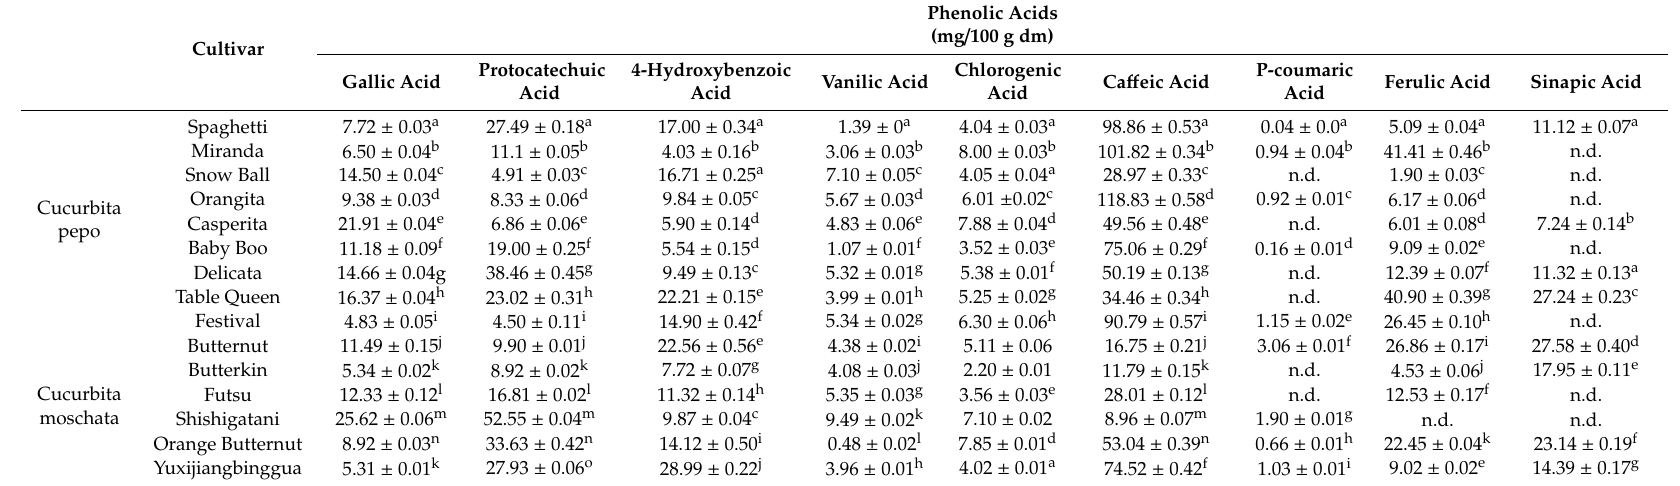
Table 2. The content of phenolic acids in pumpkin